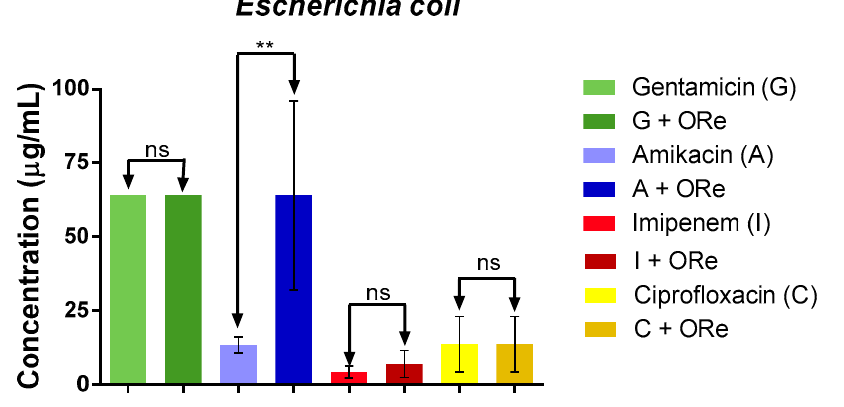
Figure 4. Minimum inhibitory concentration of antibiotics in the presence and absence of R. echinus leaf essential oil for Escherichia coli . ORe = R. echinus leaf essential oil. Statistical analysis: one-way ANOVA followed by Bonferroni post-hoc test. ** p < 0.01 indicates significant difference when R. echinus leaf essential oil was added to the medium. ns, not significant; G = gentamicin, A = amikacin, I = imipenem, C = ciprofloxacin. Data show mean + SEM from three independent experiments performed in triplicate.